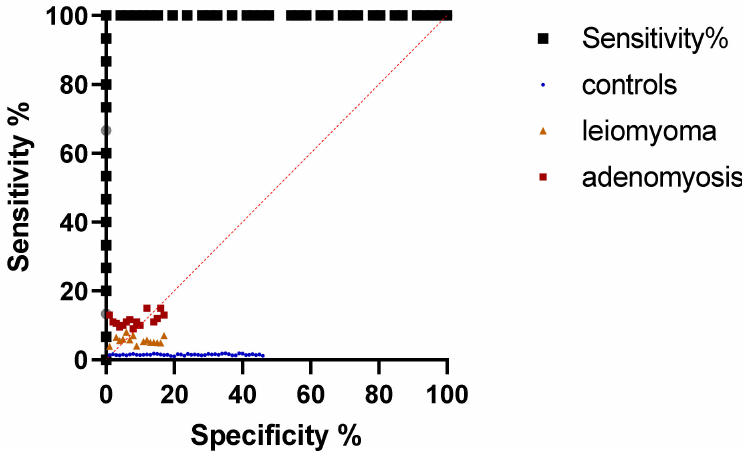
Figure 6. ROC curve of mean SR values for differential diagnosis of adenomyosis and leiomyoma from healthy uterine tissue.